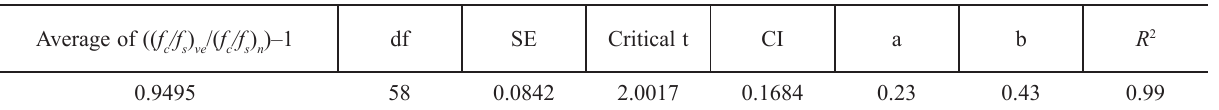
Fig. 7 Parity between the observed friction factor ratio, (( f c /f s ) exp ) and the model predicted values, (( f c /f s ) cal ) (Eq. 19)